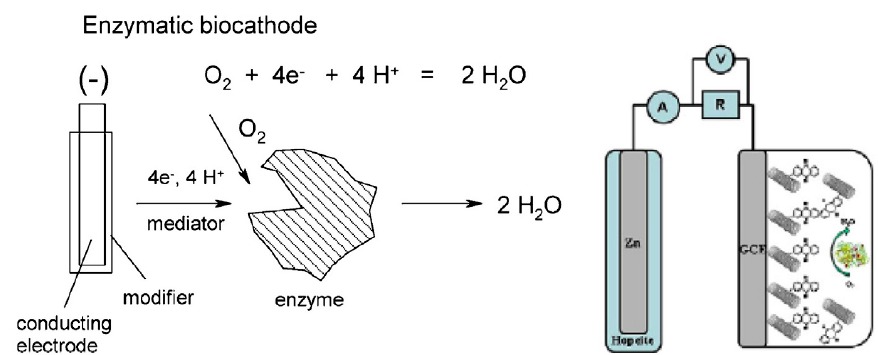
Figure 30. Oxygen reduction on an enzymatic biocathode, and scheme of the complete biobattery, comprising a Zn anode onto which a hydrated zinc phosphate layer was grown, and a glassy carbon cathode modified by biphenylated SWCNTs and an enzyme. Reproduced from [139] with permission. Copyright 2013 from Elsevier.